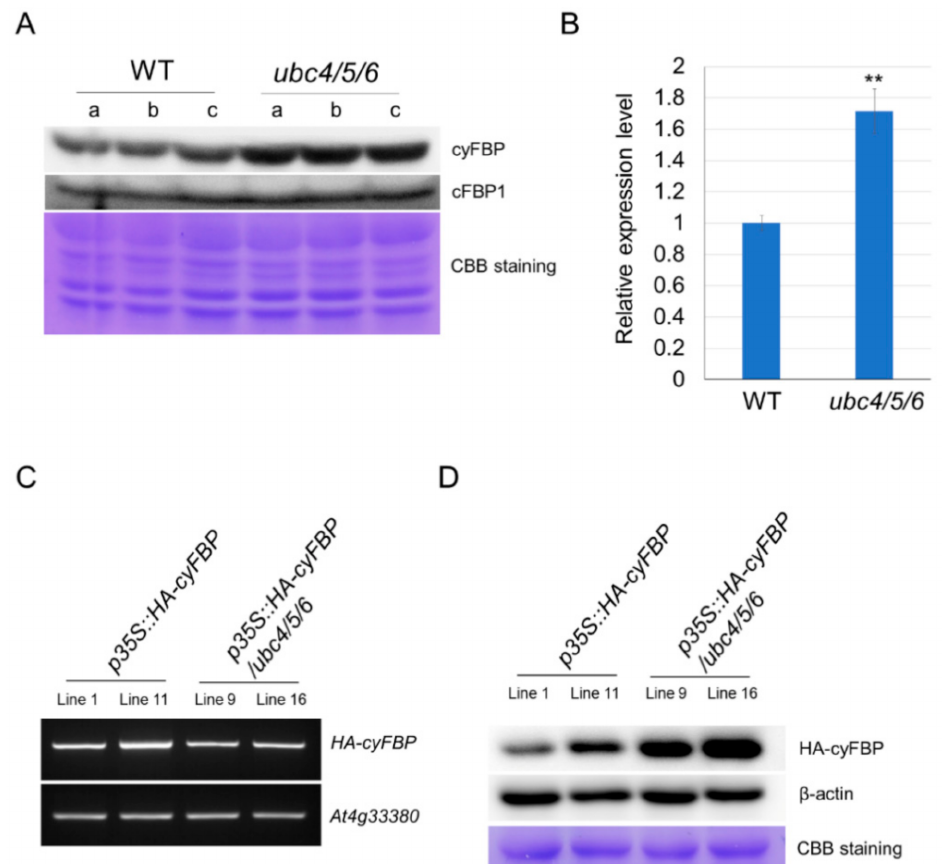
Figure 3. Analysis of cyFBP and cFBP1 in the WT and ubc4/5/6 mutant. ( A ) Analysis of cyFBP and cFBP1 in the WT and ubc4/5/6 mutant plants. Total proteins were extracted from mature leaves of the 5-week-old plants and used for Western blotting analysis with anti-cyFBP and anti-cFBP1 antibodies. Three replicate samples from each background were analyzed. The Coomassie Brilliant Blue (CBB) staining of the gel at the lower panel shows the evenness of sample loading. ( B ) Quantitative analysis of the band intensity in ( A ). The intensities of the cyFBP bands were measured using ImageJ. The relative expression level is used for the cyFBP level in the mutant with the level in the WT set as 1.0. The error bars indicate standard deviations. Student’s t -test was performed to determine the significance of the difference between the WT and ubc4/5/6 mutant (**: p < 0.01). ( C ) Transcript analysis of HA-cyFBP in the WT and ubc4/5/6 backgrounds. The construct p35S::HA-cyFBP was introduced into the WT and ubc4/5/6 mutant. Transgenic lines (T3) were screened for HA-cyFBP expression and two transgenic lines for each background with similar levels of HA-cyFBP as determined by RT-PCR were selected. The transcript level of At4g33380 was used as a reference. ( D ) Analysis of HA-cyFBP protein level in the WT and ubc4/5/6 backgrounds. Transgenic lines (two for each background) with a similar level of HA-cyFBP transcripts as shown in ( C ) were used. Total proteins were extracted from 2-week-old seedlings and the HA-cyFBP protein was detected using Western blotting with an anti-HA antibody (top panel). β -actin protein was used as a loading control (middle panel). Additionally, the gel was stained with Coomassie Brilliant Blue (CBB) to show the evenness of sample